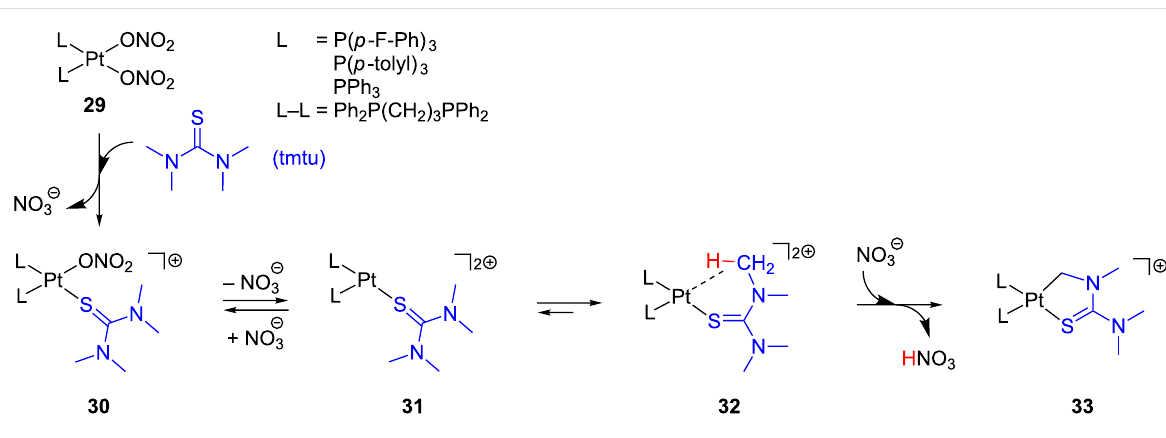
Scheme 16: Coordination of tmtu to 29 and subsequent C–H bond activation via three-coordinate species 31 and 32